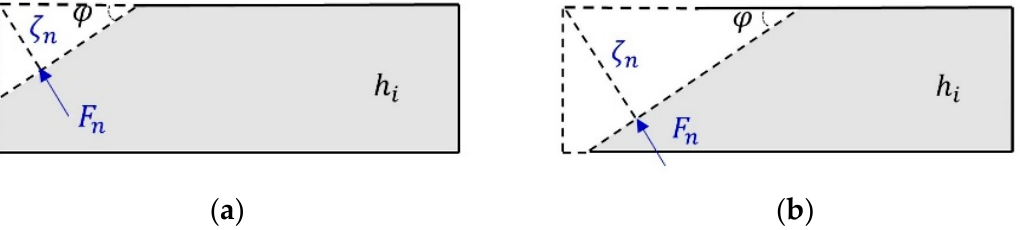
Figure 8. Case II-shoulder collision: wedge-shaped edge indentation. ( a ) Indentation does not go through the ice thickness; ( b ) Indentation penetrates through the ice thickness.